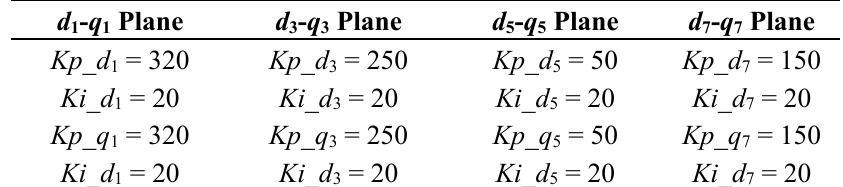
Table 4. Key parameters for inner proportional and integral